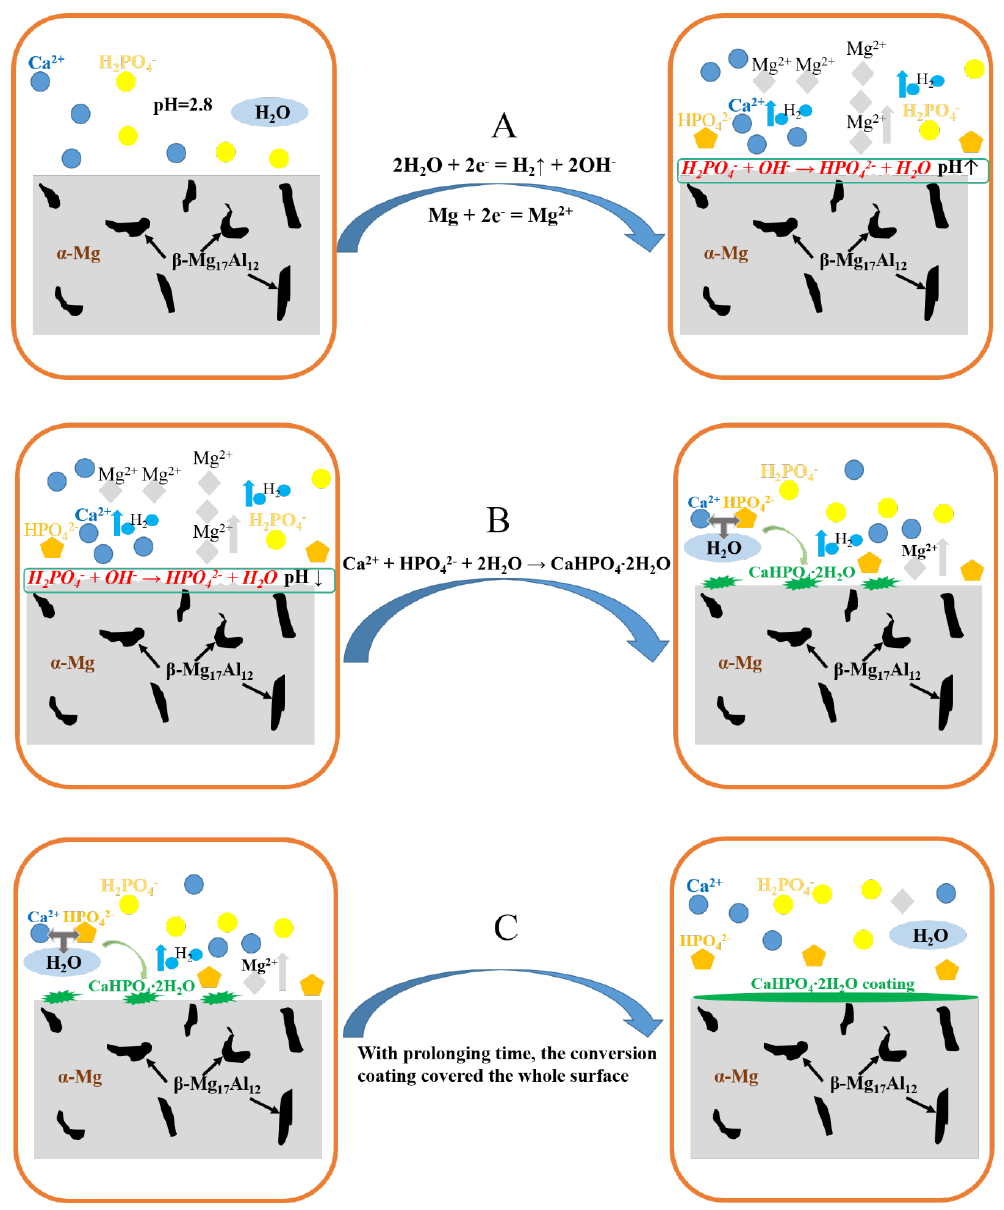
Figure 11. Formation mechanism of calcium phosphate conversion coating on AZ91D magnesium alloy: ( A ) corrosion and activation; ( B ) deposition of DCPD; ( C ) the whole coverage of DCPD coating.